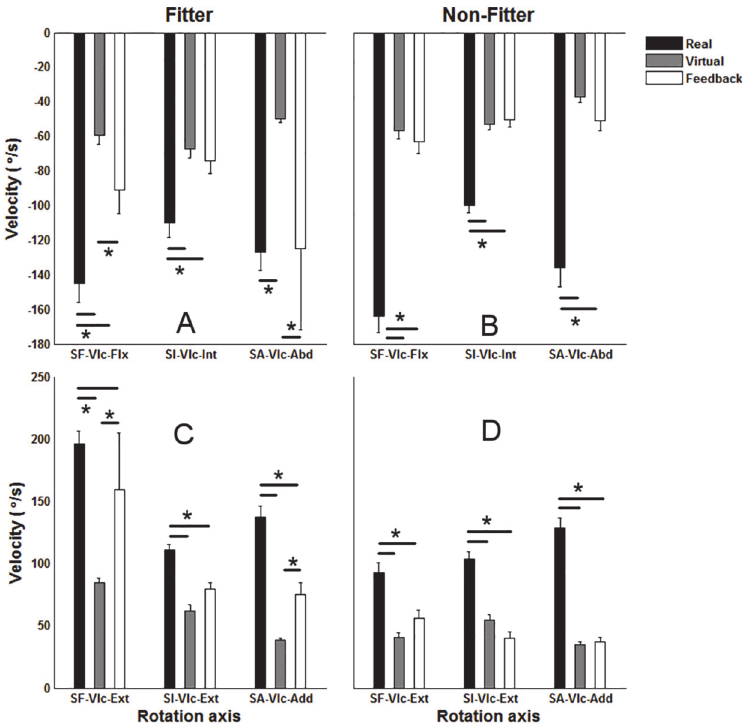
Fig 4. The mean and standard error of maximum of angular velocity profiles of shoulder flexion (SF), internal rotation (SI) and abduction (SA) across participants and cycles. The figures in each column illustrate the outcomes for each of the object types ( “ fitter ” and “ non-fitter ” ). SF, SI and SA stand for shoulder flexion, internal rotation and abduction respectively. SF-Vlc-Flx and SF-Vlc-Ext stand for maximum angular velocity in flexion and extension of shoulder, SI-Vlc-Int and SI-Vlc-Ext stand for maximum internal and external rotation of shoulder, and SA-Vlc-Abd and SA-Vlc-Add stand for maximum abduction and adduction of shoulder. * indicate a significant pairwise comparison between Real, Virtual and Virtual environment with feedback (Feedback) (p <